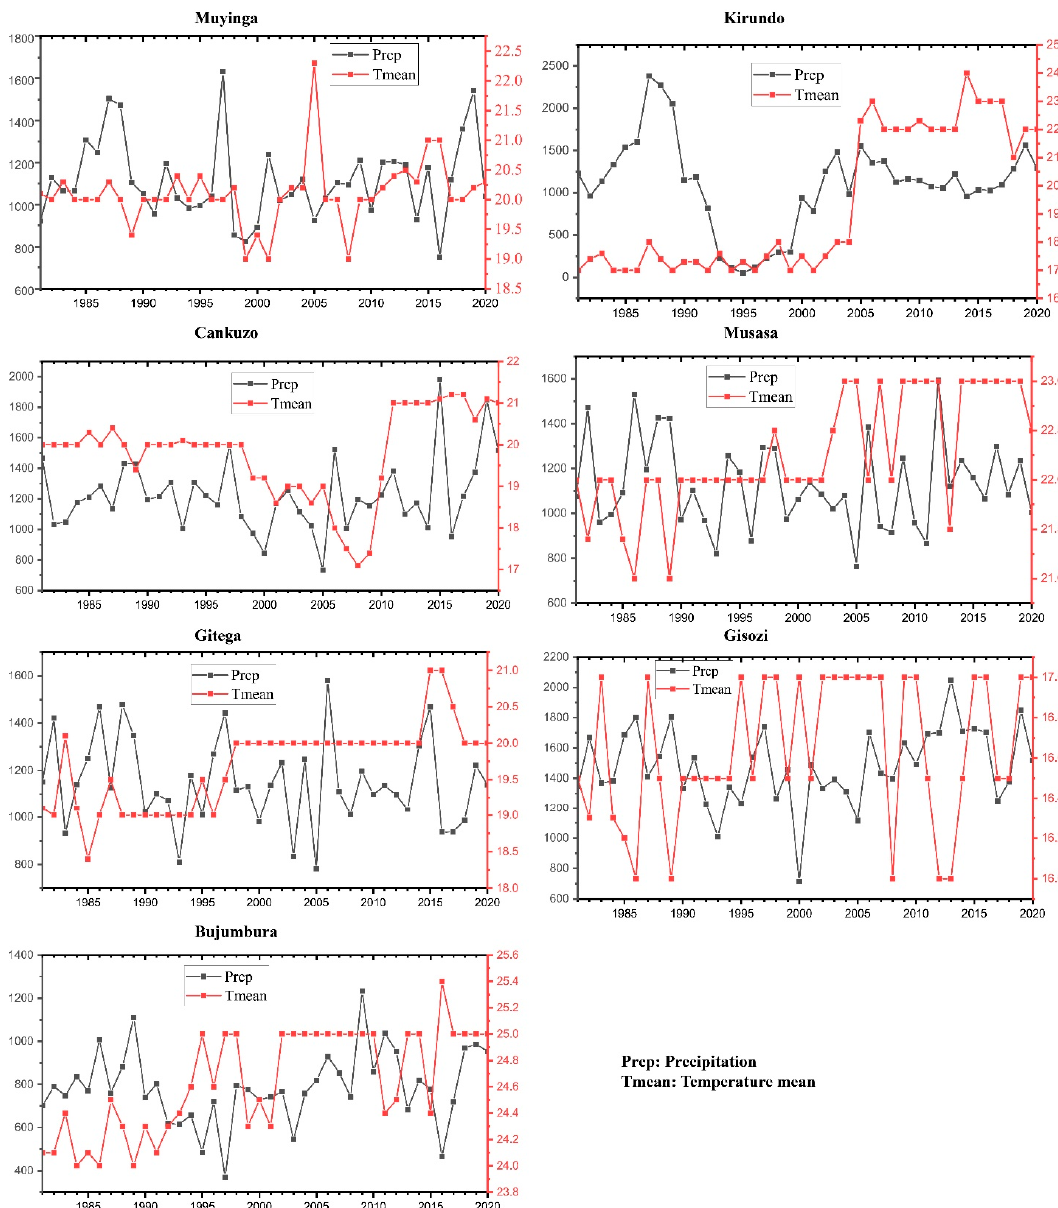
Figure 2. The correlation of annual mean precipitation and annual mean temperature.